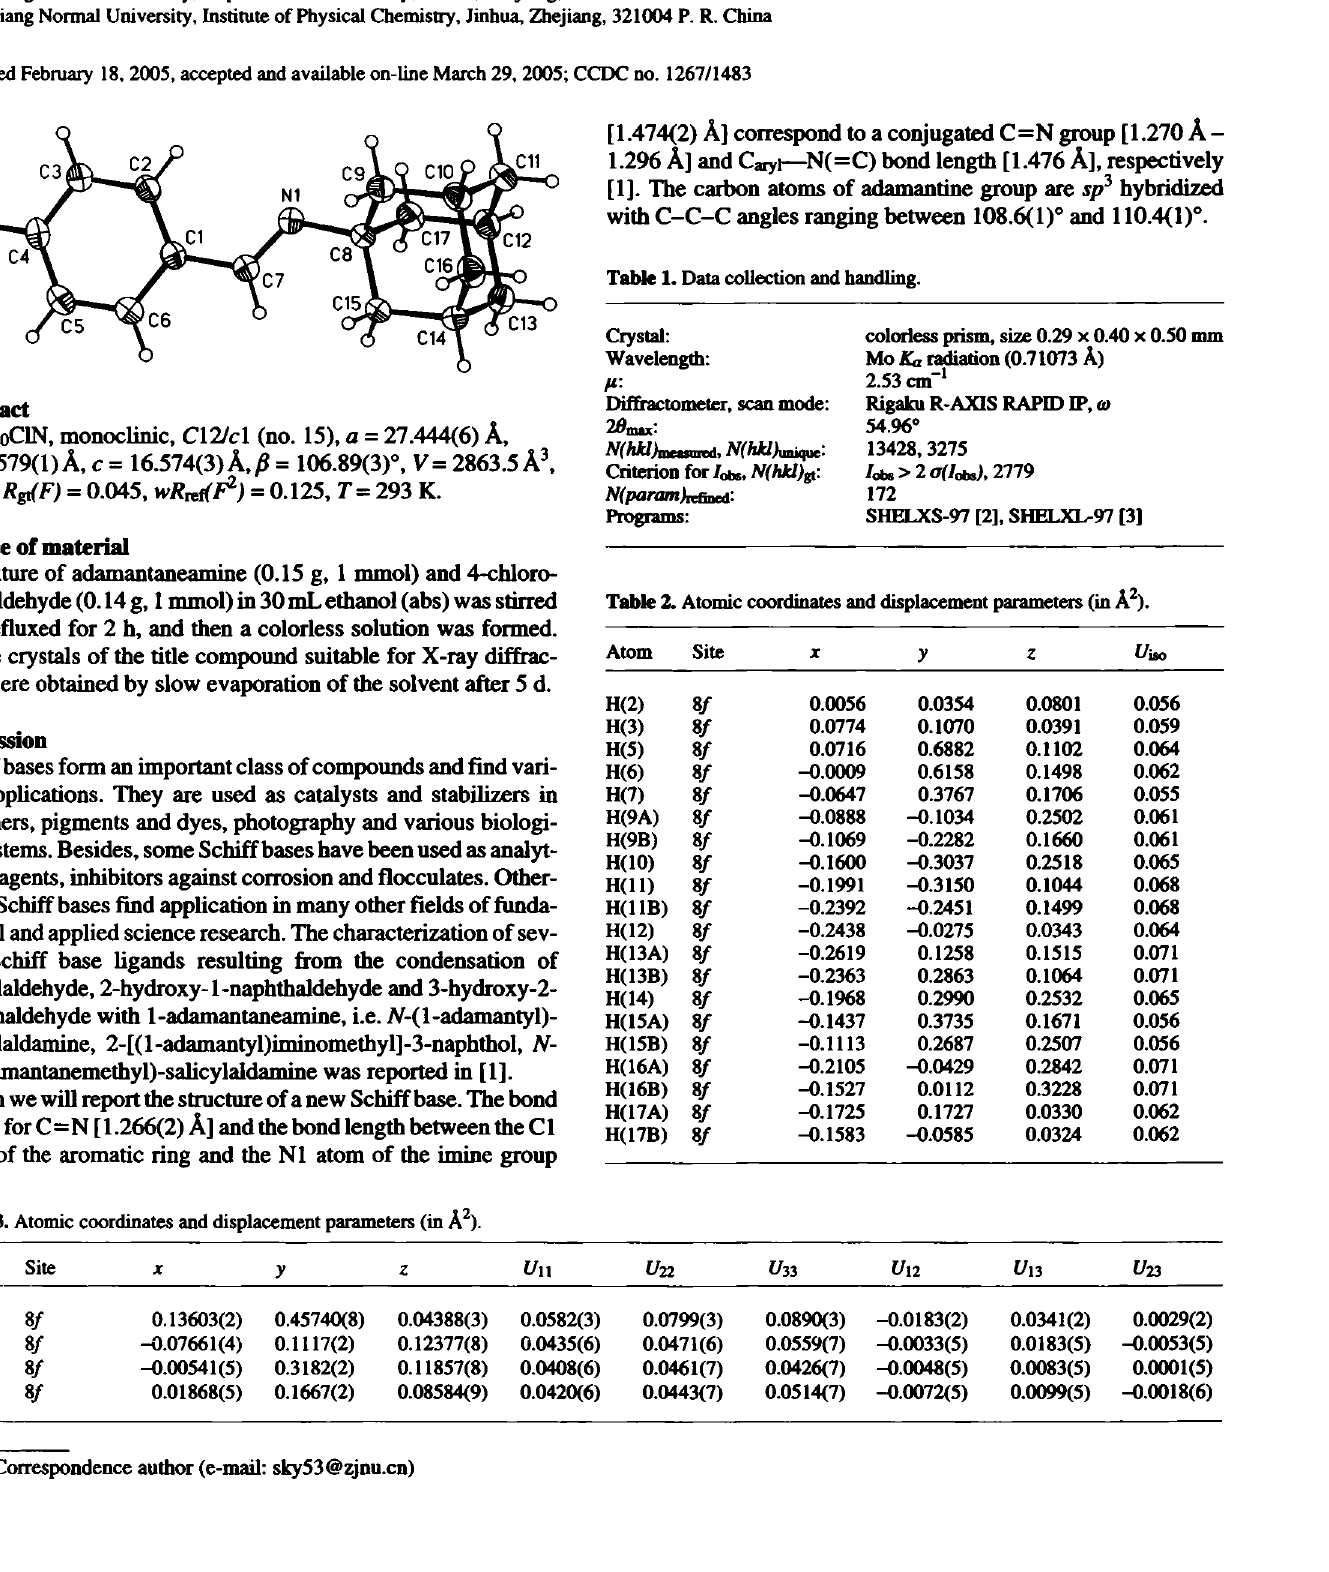
Table 3. Atomic coordinates and displacement parameters (in A 2